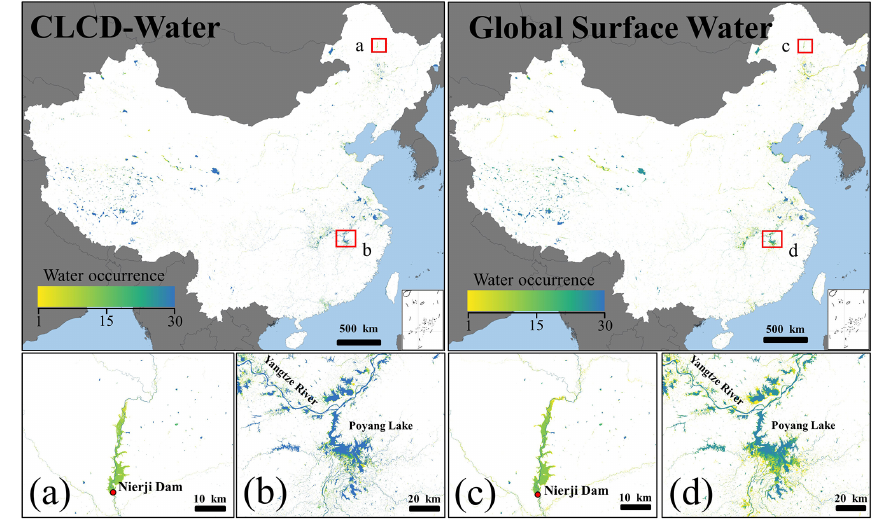
Figure 11. Annual water occurrence (1985–2018) derived from water extent of CLCD and GSW, with close-up maps located in Nierji Dam (a, c) and Poyang Lake (b, d) .